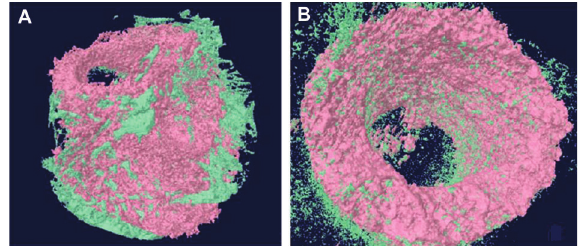
Figure 3. Micro-CT image of the magnesium scaffold: the new bone tissue in-growth 3 months post-operation ( A ). Micro-CT image of hydroxyapatite scaffold: visible new bone scattered on the surface of hydroxyapatite 3 months post-operation ( B ) (green indicates newly generated bone tissue).